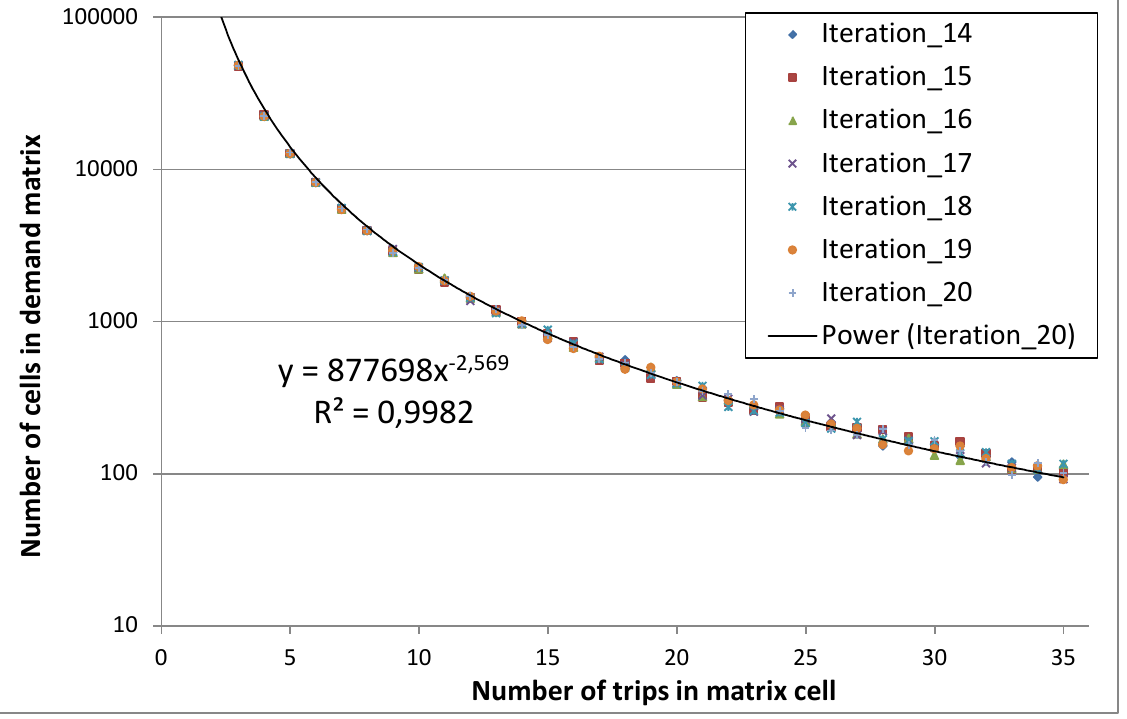
Figure 6. Distribution of trips in the car demand matrix for different iterations Although the overall distribution of trips in the matrix is quite stable, there are considerable changes at the cell level. In a given iteration of the model run, the number of non-empty cells is about 270,000, of which about 150,000 cells (55%) contain one trip. In the next iteration, about 117,000 non-empty cells (42%) transforms into empty cells, of them 93,000 (34% of non-empty cells, or 80% of transformed non-empty cells) were cells with one trip in the previous iteration. Similarly, there are changes in the opposite direction: about 117,000 empty cells transforms into non-empty cells in the next iteration. This “flip-flop” situation along the iterations is quite stable: Table 1 shows average values and standard deviation of above numbers of transformations for all different pairs of matrices for 10 iterations of the model. Table 1. Sparseness of demand matrices and pairwise comparison of matrices from different iterations Parameter Average Total non-empty matrix cells